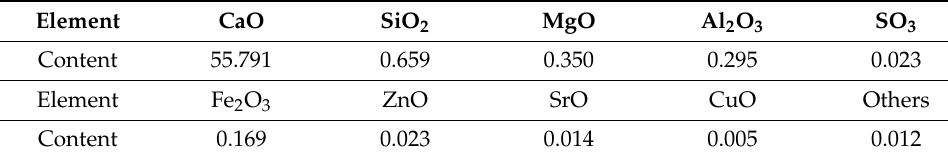
Table 2. Chemical composition of calcite powder samples (weight %).